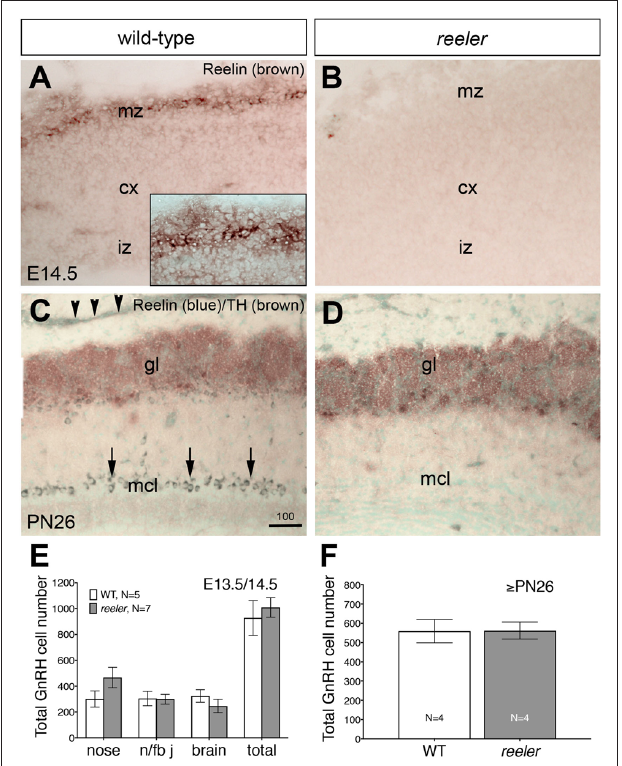
FIGURE 7 | Distribution of GnRH neurons is not affected in the brain of adult reeler mice. (A,B) Cresyl violet countered coronal sections through the hippocampus showing the cytoarchitecture of the normal (A) and reeler (B6C3Fe a/a-Reln/J ; B ) mice. As expected, the distinct laminar structure of the hippocampus proper (i.e., CA1, CA2 and CA3) and dentate gyrus (dg) of the normal mouse (A) was disrupted in the reeler mouse (B) . (C–F) Photomicrographs showing GnRH immunoreactivity (black arrows) in the hypothalamus of the same PN26 WT (C) and reeler mice (D) analyzed in (A,B) . No differences in the morphology of the GnRH cells or their terminal fields, the number of cells or their distribution was observed between WT and reeler mice. (E,F) Photomicrographs showing similar GnRH-immunoreactivity in coronal sections of WT (E) and Reelin null mice (F) median eminence (me). No observable alterations in GnRH staining was present. Bar in (A) = 100 µ m (same in B ). Bar in (C) = 100 µ m (same in D ). Bar in (C) inset = 25 µ m (same as inset in D ). Bar in (E) = 50 µ m (same in F